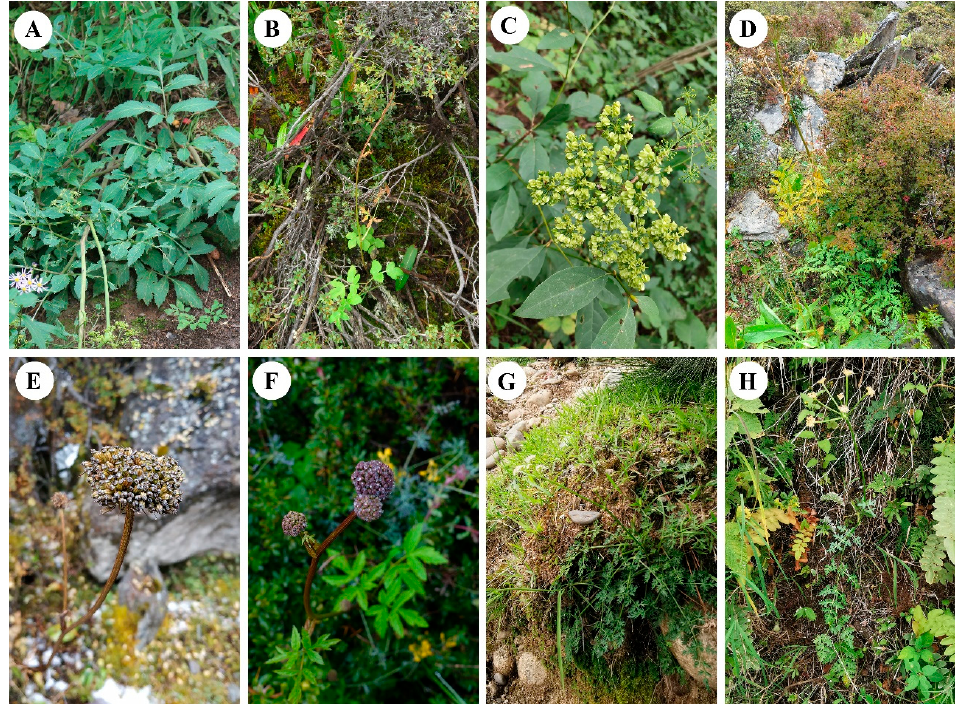
Figure 1. Plants of Hansenia , Haplosphaera and Sinodielsia . ( A ) Han. forbesii , ( B ) Han. forrestii , ( C ) Han. oviformis , ( D ) Han. weberbaueriana , ( E ) Hap. himalayensis , ( F ) Hap. phaea , ( G ) S. microloba and ( H ) S. yunnanensis .